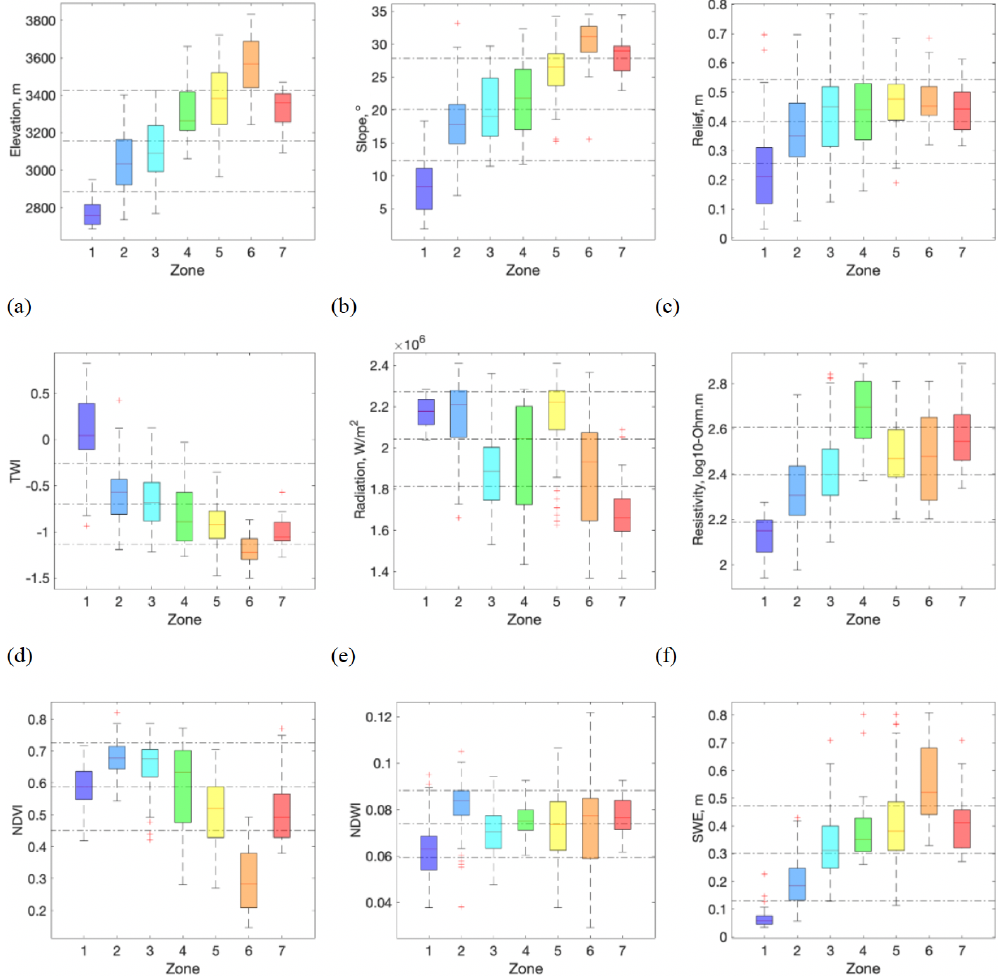
Figure 5. Box plots of hillslope pattern features: (a) elevation, (b) slope, (c) relief, (d) TWI, (e) annual net potential radiation, (f) bedrock electrical resistivity (top 20m), (g) peak NDVI in 2018, (h) NDWI (at peak NDVI) in 2018, and (i) peak SWE in 2018. The horizontal lines are the overall mean and plus/minus 1 standard deviation. Table 1. Summary of the features in each zone based on Figs. 5 and